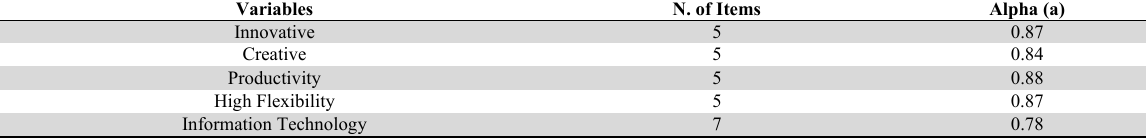
The results of the Cronbach Alpha for measuring the reliability N= 615 Variables N. of Items